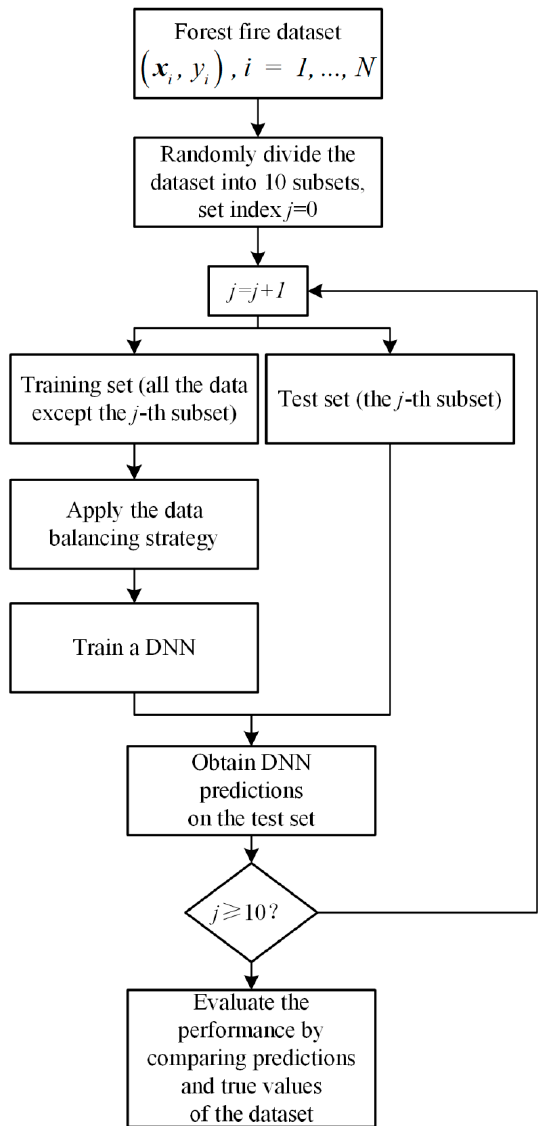
Figure 4. Procedure of the 10-fold cross-validation.